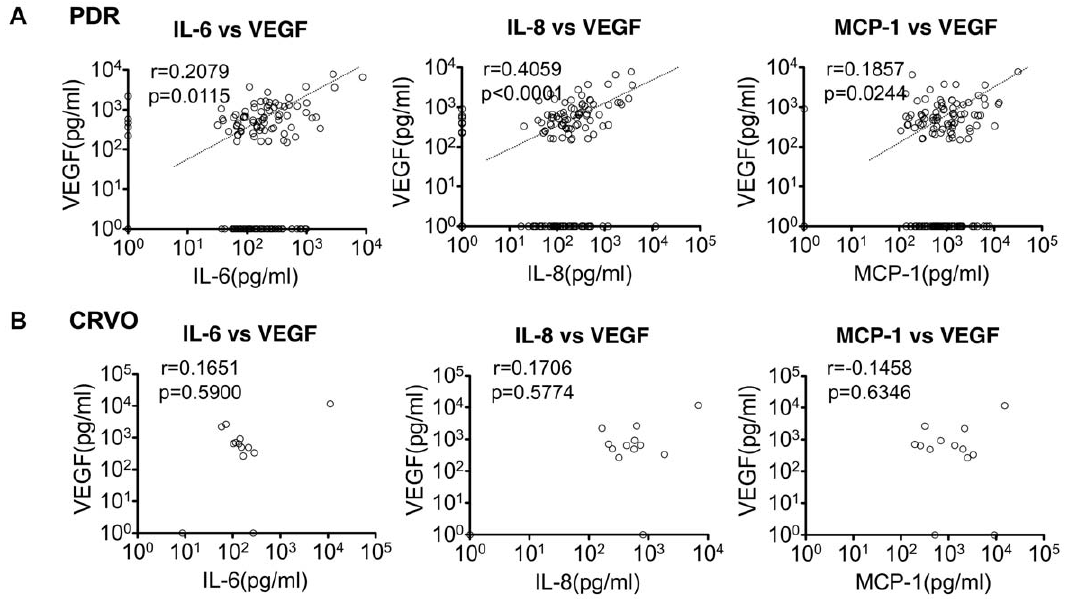
Figure 4. VEGF independently contribute to the pathogenic process of PDR and CRVO. Spearman’s correlation analysis between VEGF and IL-6/IL-8/MCP-1 in patients with PDR (n=147) or CRVO (n=13) are shown. In each disease, total of three combinations (VEGF/IL-6, VEGF/IL-8, and VEGF/MCP-1) were analyzed, and calculated p- and r-values which indicating the accuracy of correlation.